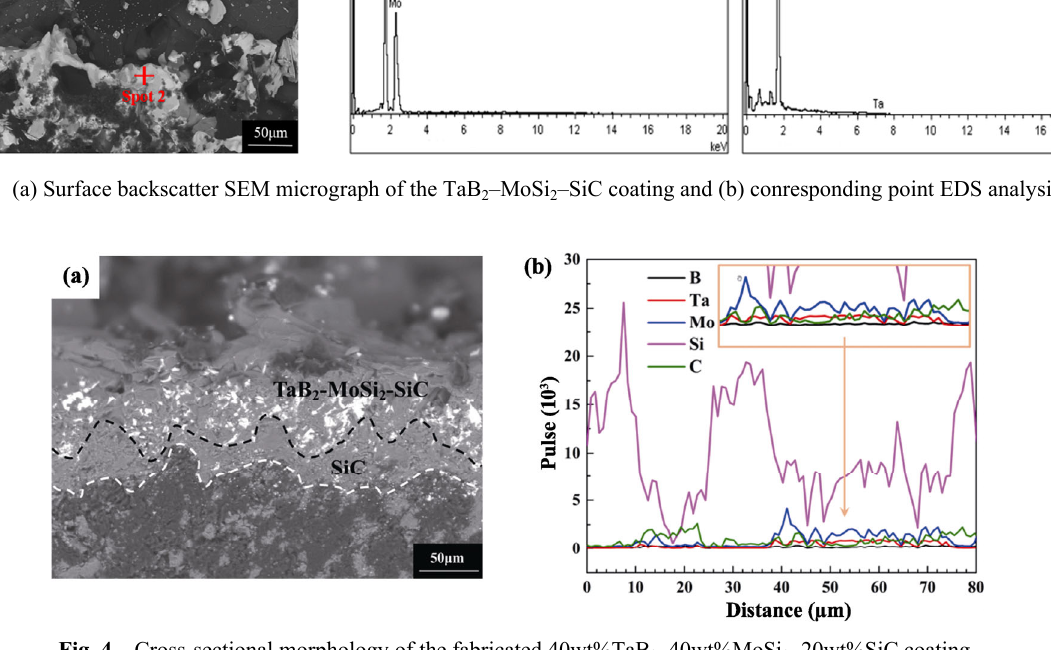
Fig. 4 Cross-sectional morphology of the fabricated 40wt%TaB 2 –40wt%MoSi 2 –20wt%SiC